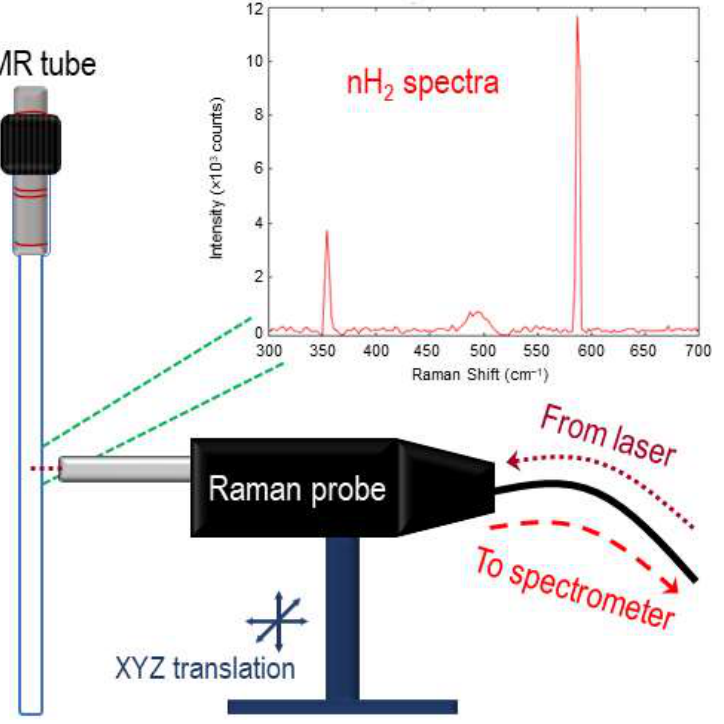
Figure 3. Raman collection setup. Bifurcated fiber-optic-coupled Raman probe on XYZ translational stage is directed to the center volume of a valved NMR tube, allowing for the collection of rotational Raman spectroscopy of the isomerically evolving H 2 gas.